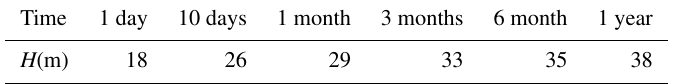
Table 1. Wave height prediction for the Atlantic tropical zone.